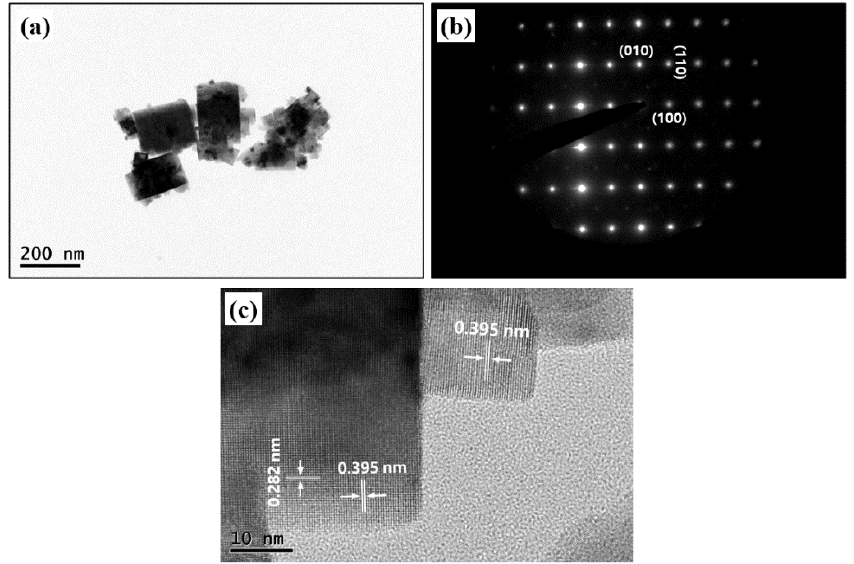
Figure 14. ( a ) TEM image, ( b ) SAED pattern, and ( c ) HRTEM image of K 0.5 Na 0.5 NbO 3 particle of the MPB composition synthesized in glycothermal conditions at 200 °C for 12 h.